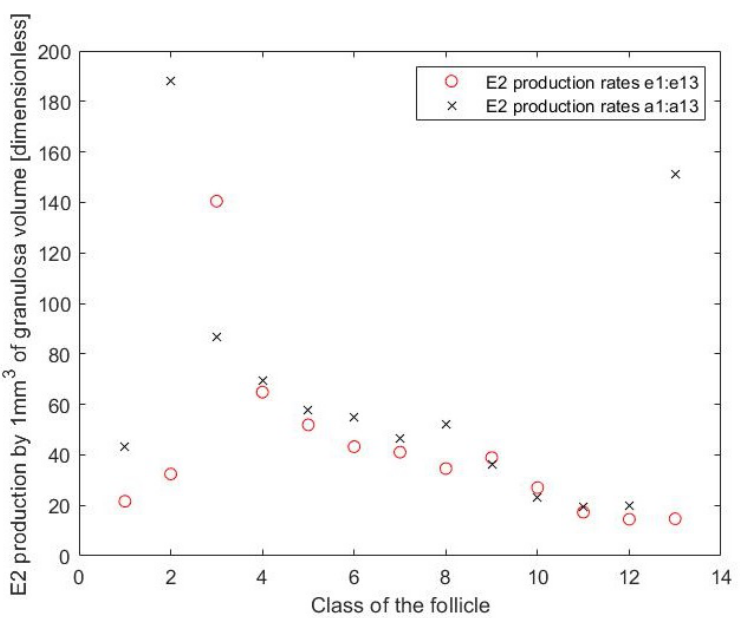
Figure 8. Output of E2 production from Equation (4). “Class of the follicle” refers to terms e 1 to e 13 and a 1 to a 13 . e 1 , e 2 and e 3 (class 1 to 3) and a 1 , a 2 and a 3 (class 1 to 3) describing the production rate by healthy follicles of ReF, SeF and DmF, respectively. e 4 to e 13 (class 4 to 13) and a 4 to a 13 (class 4 to 13) stand for declining production rate by atretic follicles throughout their consecutive days of atresia. Table 1. Optimised parameter values for Equation (5) describing the effect of IGF1 and P4 on the production of E2 by 1 mm 3 of granulosa cells in different classes of healthy and atretic follicles. These are unscaled values. Class of Follicle Effect of IGF1 on E2 Effect of P4 on